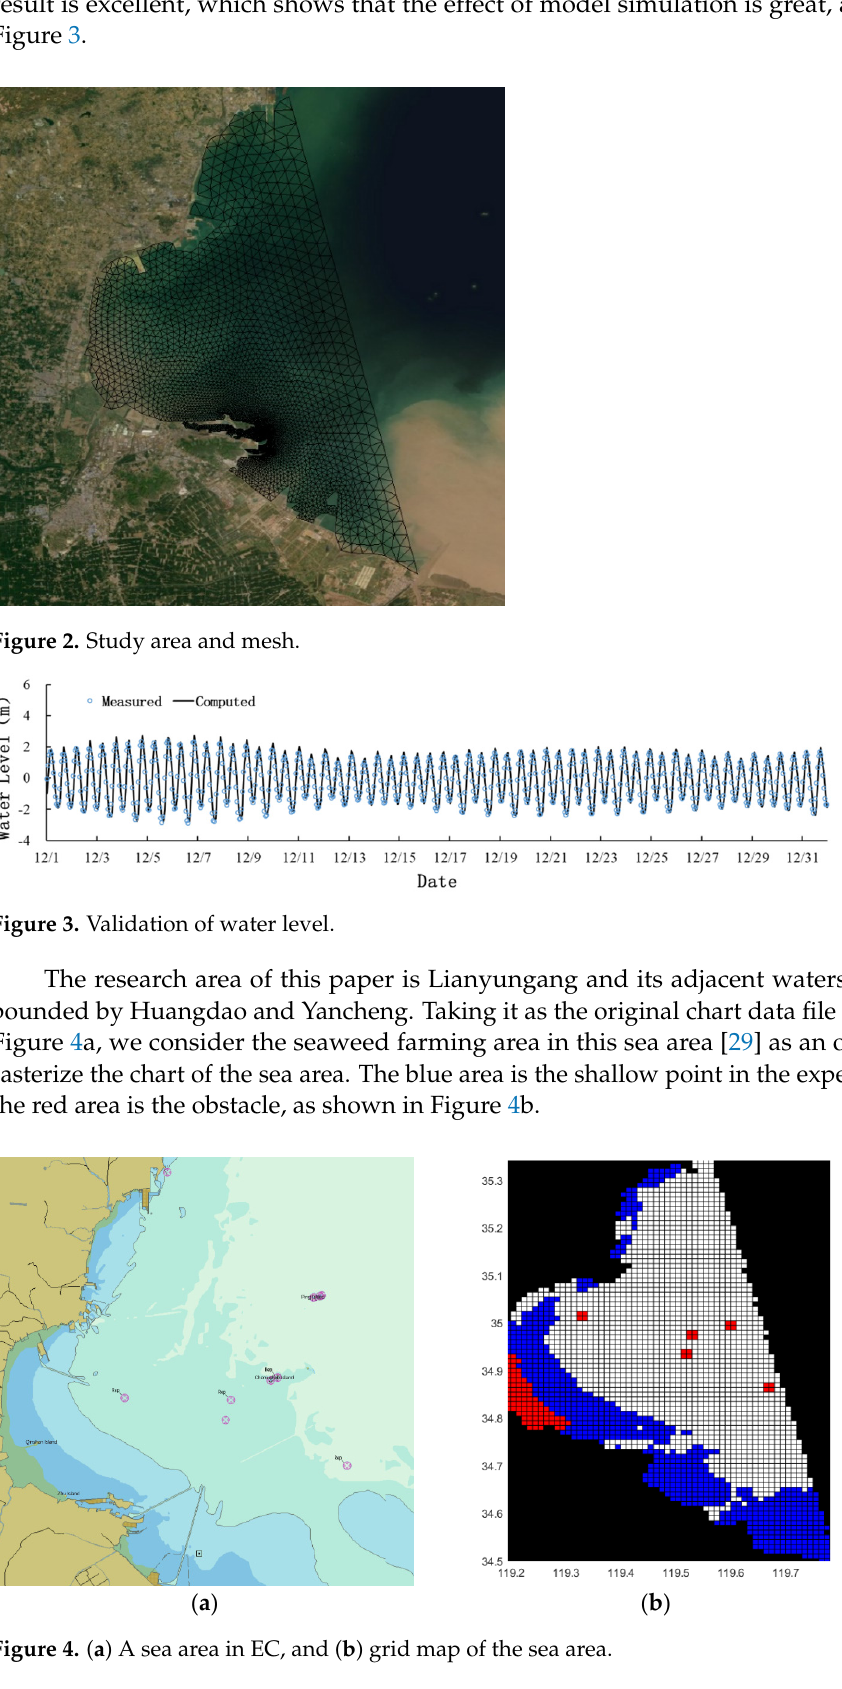
Figure 4. ( a ) A sea area in EC, and ( b ) grid map of the sea area.